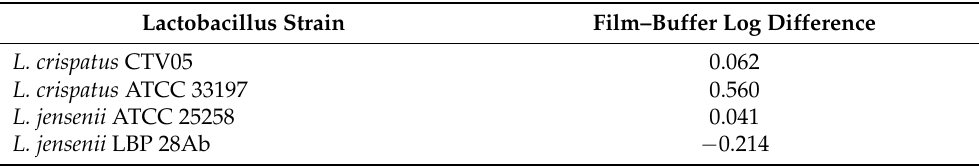
Table 1. Lactobacillus compatibility with the PNP Films.